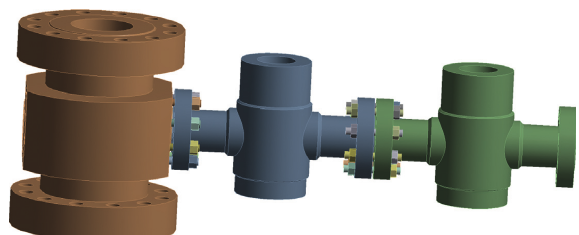
Figure 4: The finite element model